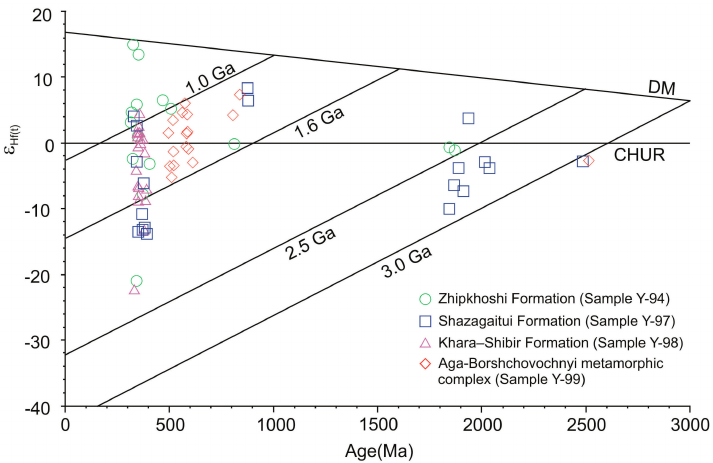
Figure 8. Plots of crystallization age (Ma) versus ε Hf(t) for zircon grains from Aga–Borshchovochnyi metamorphic complex and siliciclastic rocks of the Chiron Basin. Data from Table S3.